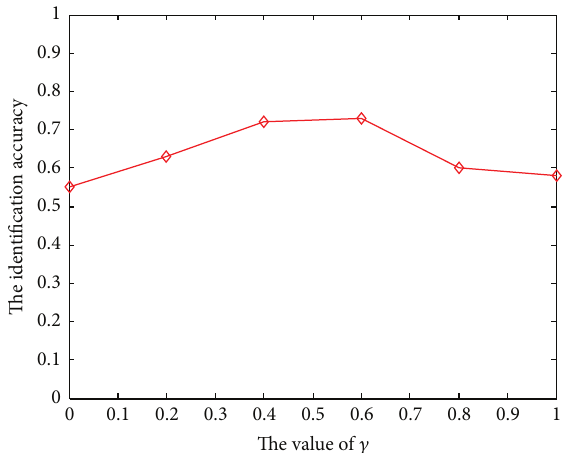
Figure 4: The influence of parameter 𝛾 in sentiment